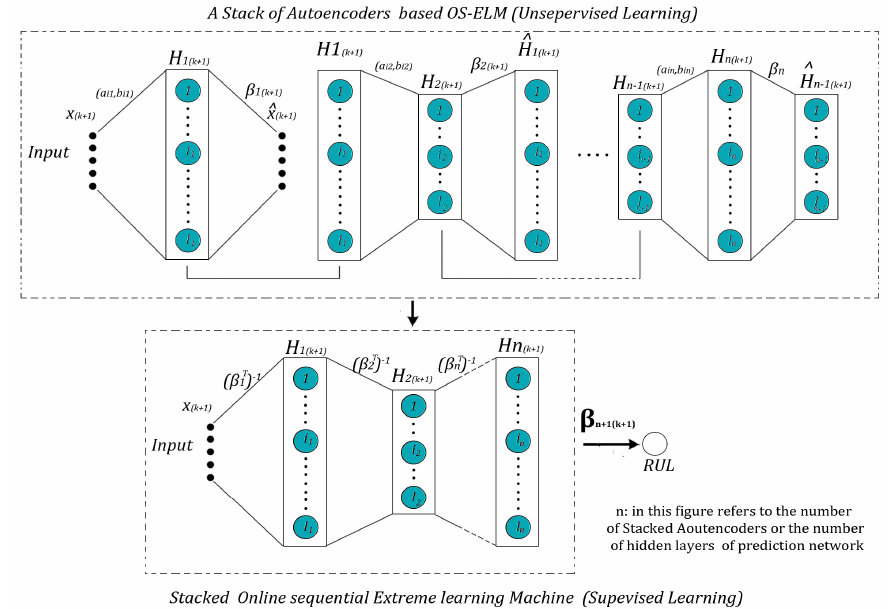
Figure 3. Proposed NN (Neural Networks) for RUL prediction.